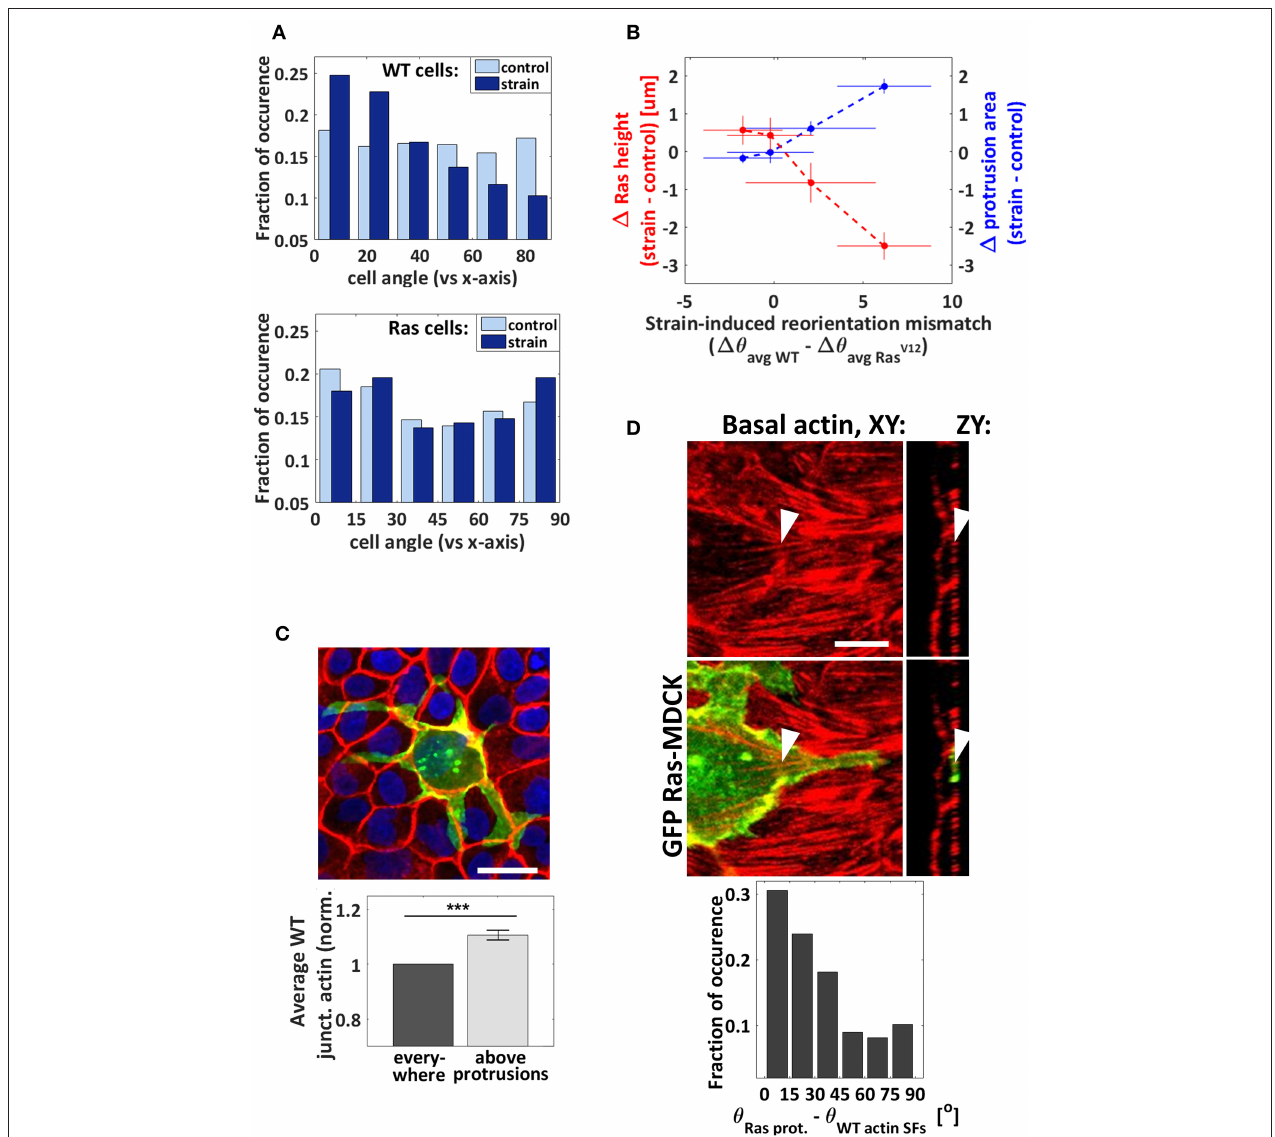
FIGURE 3 | Orientation analysis. (A) Cellular reorientation response to cyclic stretching (after the substrate is returned to its unstretched condition). Normalized incidence histogram of the angle difference between the cell body direction and the stretching axis for the WT (top) and Ras V12 (bottom) cells. n WTcontrol = 5,261 cells, n WTstrain = 5,076 cells, n Rascontrol = 287 cells, and n Rasstrain = 189 cells from 3 independent strain and 3 independent control experiments. (B) Correlation between the reorientation mismatch and the strain-induced changes in average Ras V12 cell height and protrusion area. Each point corresponds to one pharmacological condition (from left to right: ROCK inhibitor, blebbistatin, FAK inhibitor, and DMSO). The reorientation mismatch is the difference between the strain-induced reorientation of the WT cells ( 1θ avg WT ) and that of the Ras V12 cells ( 1θ avg Ras ), where 1θ avg = θ avg strain − θ avg control . When the mismatch is zero, the degree of cell reorientation under strain is the same for Ras V12 and WT cells. When it is higher than zero, the reorientation response is greater in WT cells. (C) Top: rather extreme example of Ras V12 cell with protrusions growing preferentially at the WT-WT junctions. Scale bar is 11 µ m. Bottom: the average WT junctional actin intensity is greater above the Ras V12 protrusions than it is in average elsewhere. Control and strain DMSO conditions combined together, n = 91 images (each image contained 1–10 Ras V12 cells from 1 to 4 clusters, and hundreds of WT cells) from 3 independent control to 3 independent strain experiments. Data are mean ± s.e.m., *** P < 0.0001. (D) Top: representative confocal images of basal actin (red) and GFP-Ras V12 − (green) showing a protrusion growing parallel to neighboring actin SFs. The arrows point at the same SF in two different views. Scale bar is 6 µ m. Bottom: normalized incidence histogram of the angle difference between the protrusions and the neighboring WT actin filaments (under strain only). This analysis could not be performed for the static condition due to the scarcity of basal actin filaments in the absence of stretching. n = 190 protrusion segments from 3 independent